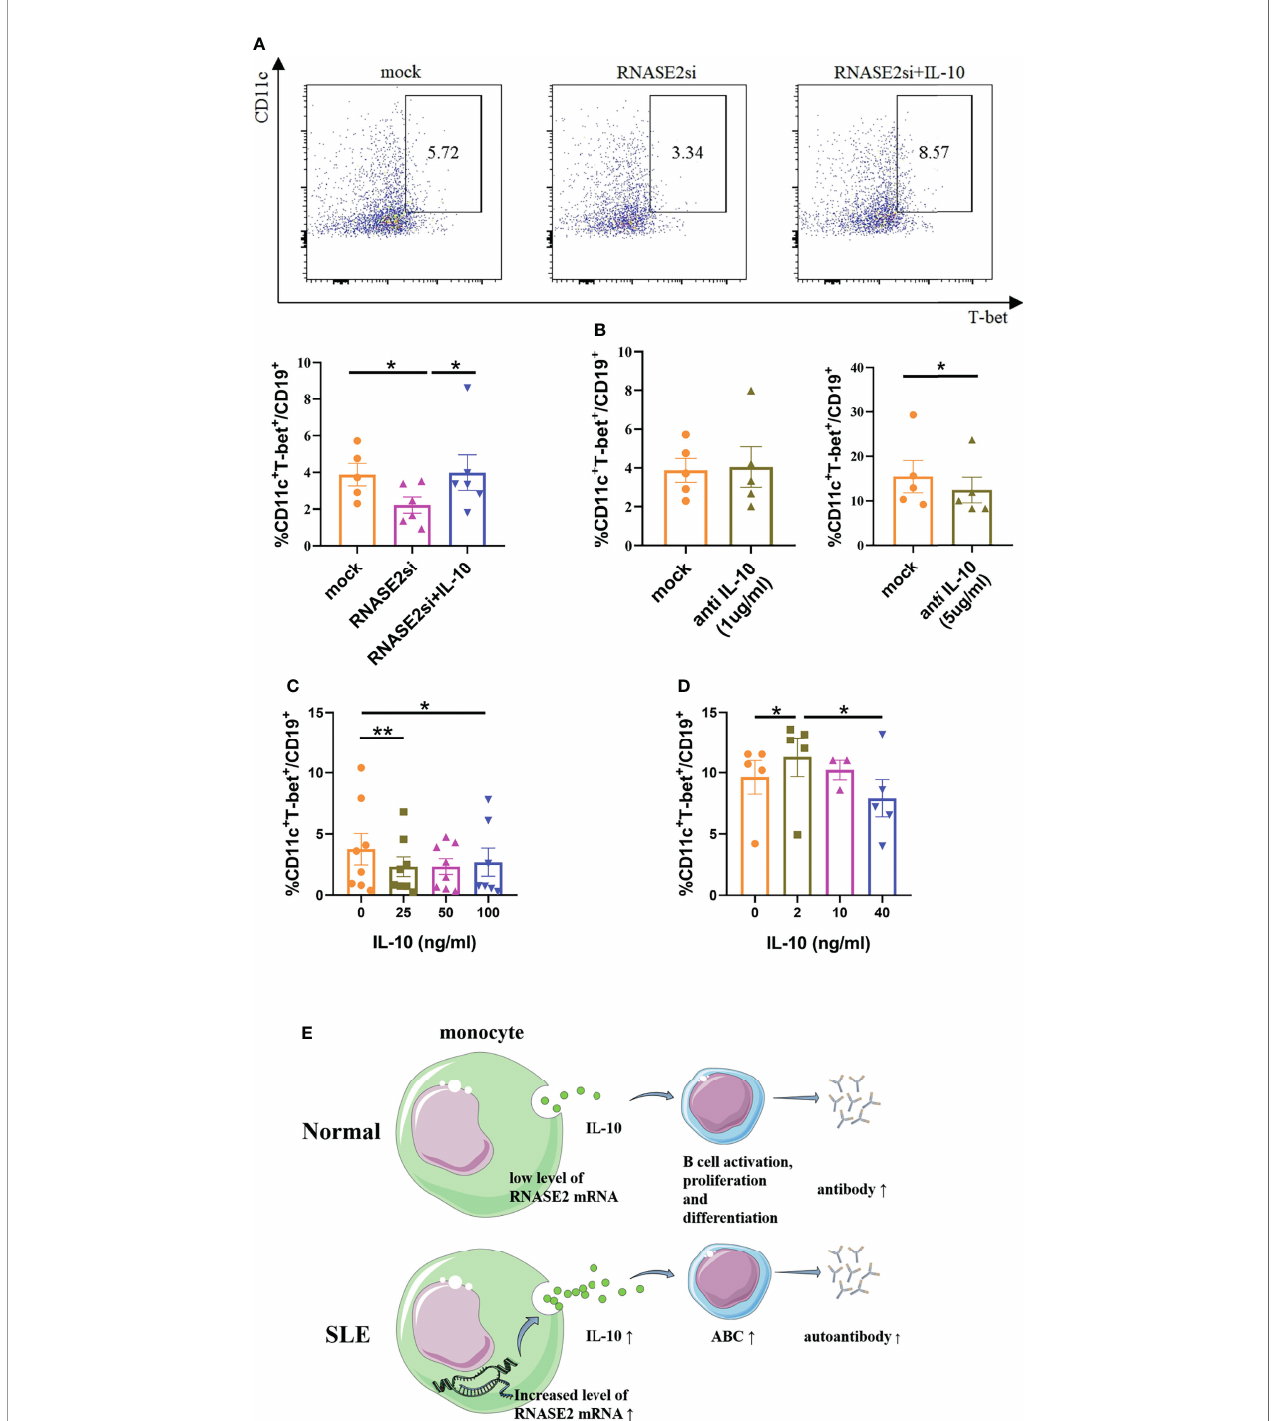
FIGURE 6 | IL-10 regulated the production of ABCs in SLE patients. (A) Lupus B cells were co-cultured with monocytes with the presence of either RNASE2 siRNA (RNASE2si) or RNASE2 siRNA plus 50ng/ml human recombinant IL-10 (RNASE2si+IL-10) (n=6). The proportion of CD11c + T-bet + B cells was restored after the replenishment of IL-10 in RNASE2 silencing group. (B) High dose anti-IL-10 (5ug/ml) but not low dose anti-IL-10 (1ug/ml) blocked the production of CD11c + T-bet + B cells in B cell and monocyte co-cultures (n=5). (C) The effect of recombinant IL-10 on the proportion of CD11c + T-bet + B cells in B-cell plus monocyte co-cultures (n=8). (D) The effect of recombinant IL-10 on the proportion of CD11c + T-bet + B cells in CD19 + B cell culture (n=5). (E) Hypothesis schema of RNASE2 pathogenetic role involved in SLE patients (picture material was from http://smart.servier.com). Data are presented as mean ± SEM, paired t test, *p < 0.05, **p <